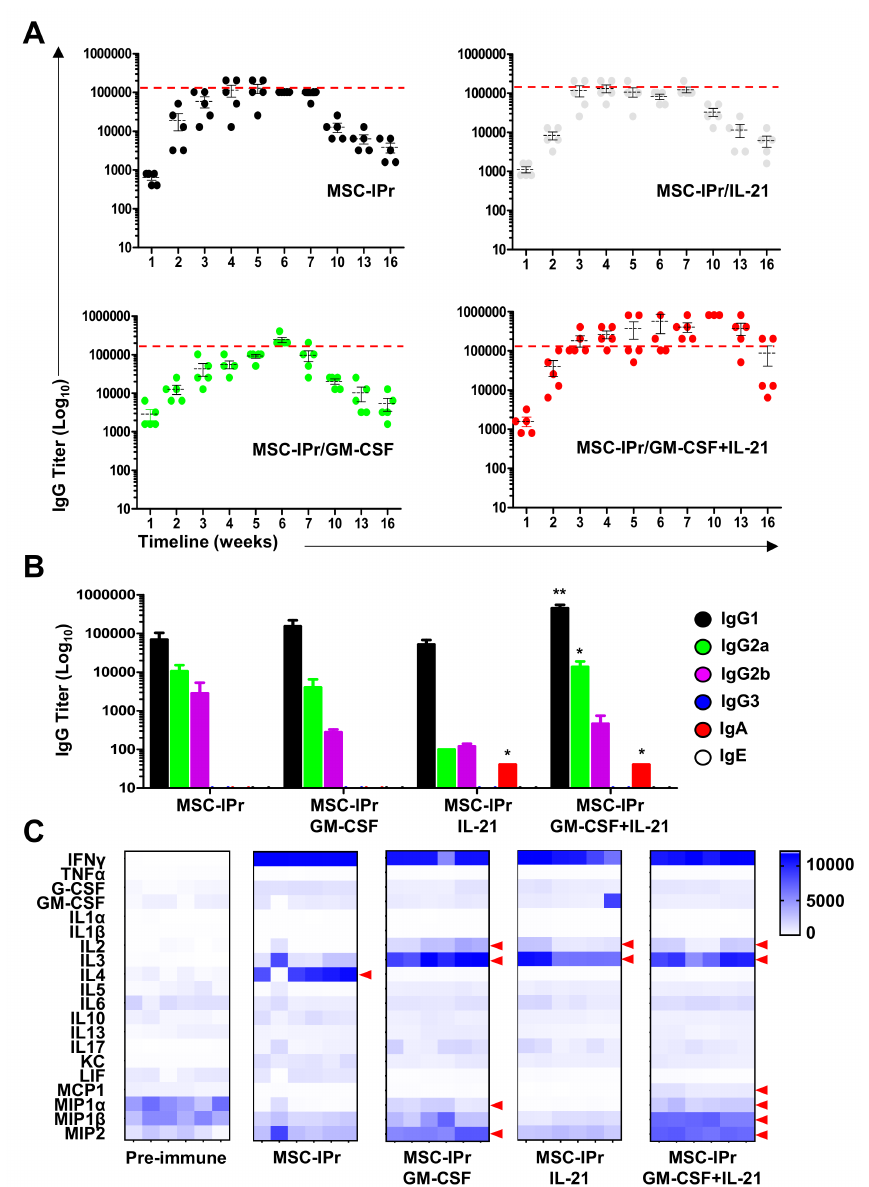
Figure 3. GM-CSF and IL-21 combination improves the immune response to allogeneic MSC-IPr. ( A ) Weekly antibody titer analysis by ELISA using sera collected from allogeneic OVA-pulsed MSC- IPr alone (black) or in combination with IL-21 (white), GM-CSF (green) or a mix of GM-CSF and IL-21 (red). The red dashed line represents the highest titer obtained with MSC-IPr alone. ( B ) Assessing antibody isotypes at week 6 in all test groups. ( C ) Multiplex cytokine analysis of in vitro-restimulated CD4 T cells cultured with ISQAVHAAHAEINEAGR-pulsed MSC-IPr. Red arrows represent detected changes in cytokine/chemokine levels compared to control groups. For panels ( A – C ), n = 5–6/group with * p < 0.05 and ** p <